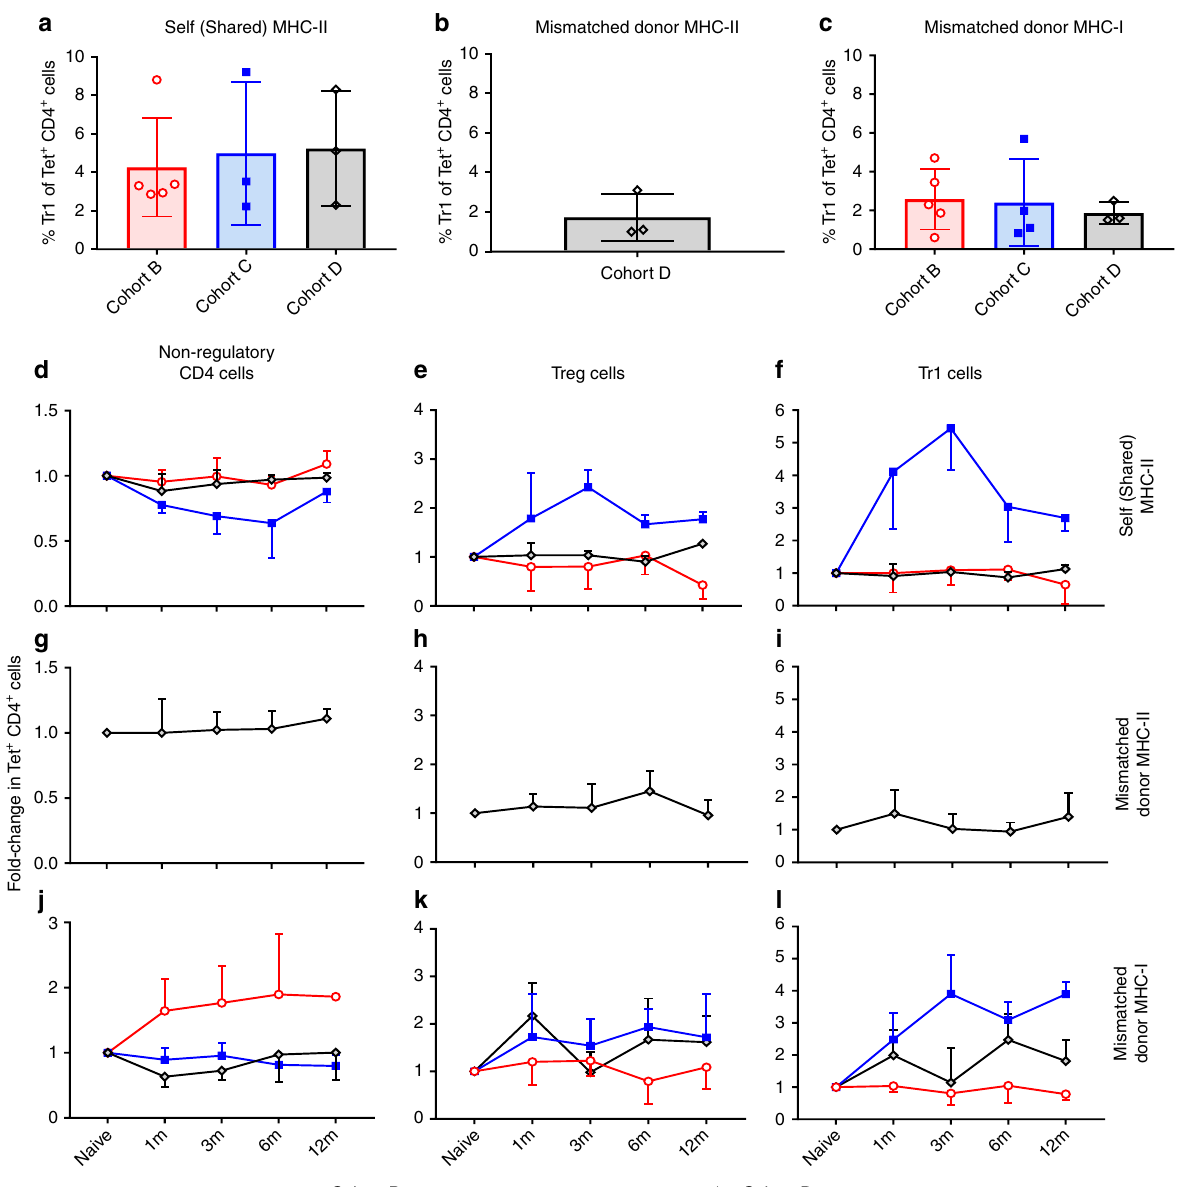
Fig. 6 Tracking of antigen-speci fi c CD4 + T cells. Tracking of non-regulatory CD4 + T cells, Tr1, and Treg cells with indirect speci fi city for self (shared) major histocompatibility complex (MHC)-II, mismatched donor MHC-II, and mismatched donor MHC-I peptides among Cohort B ( n = 5), C ( n = 3 or 4), and D ( n = 3) monkeys. a – c At baseline, the percentage of Tr1 cells within tetramers + CD4 + T cells with indirect speci fi cities for a self (shared) MHC